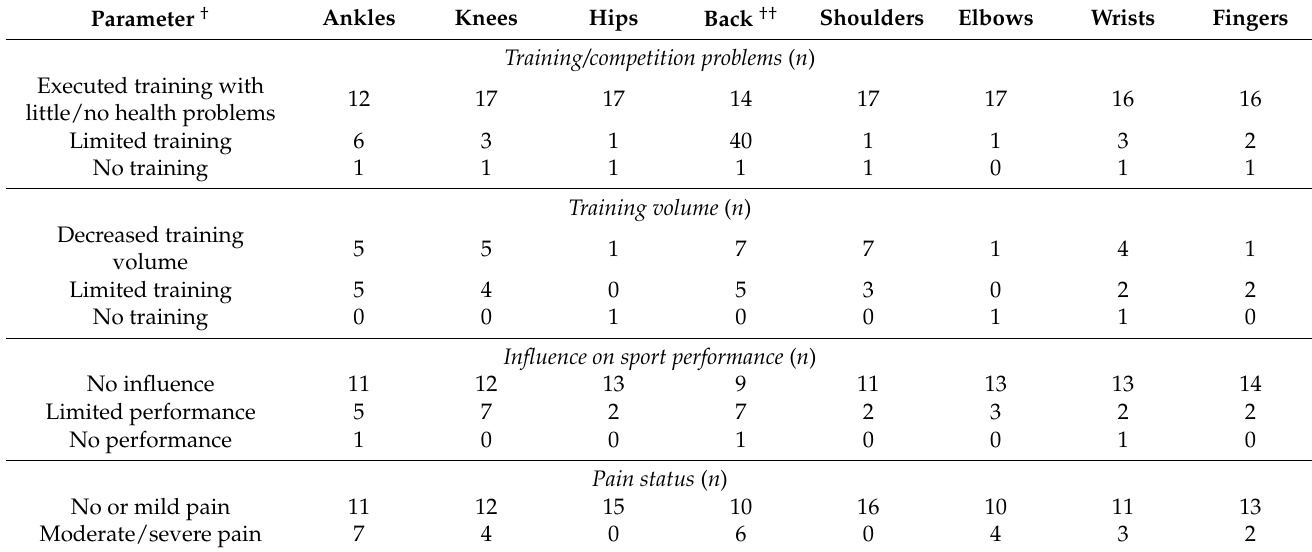
Table 3. Injury assessment.